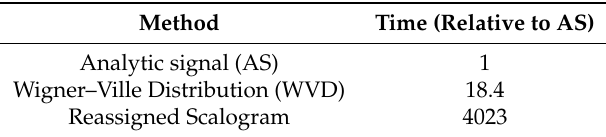
Table 2. Computation time needed for calculating the